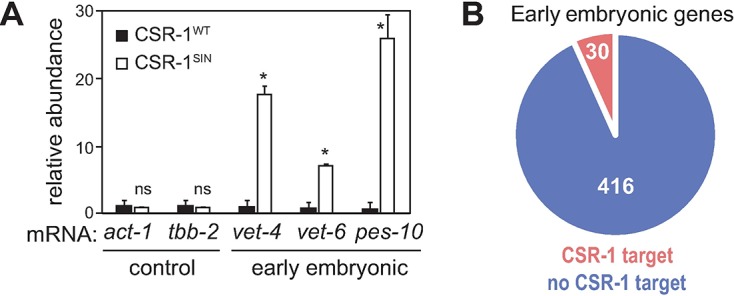
The slicing activity of CSR-1 is required to inhibit EGA.(A) Detection of EGA transcripts by RT-qPCR in gonads from animals of the indicated genotypes. The csr-1(tm892) animals were expressing either wild-type CSR-1 (CSR-1WT), or a CSR-1 variant with mutations compromising its slicing activity (CSR-1SIN); only the gonads from the latter strain expressed embryonic genes. Each bar represents the mean of three independent biological replicates. Error bars and p-values indicated as explained before. (B) Among a group of 446 early-expressed embryonic genes, only 30 are potentially targeted by CSR-1, based on the presence of antisense 22G RNAs associated with CSR-1.